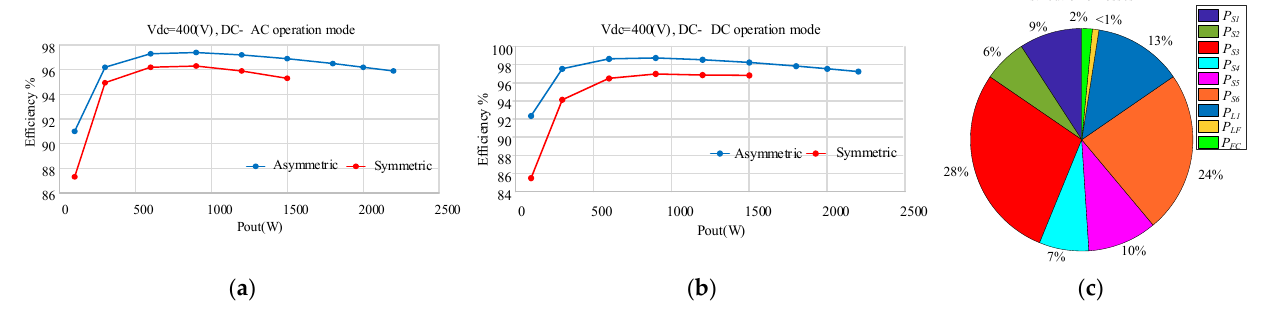
Figure 15. Experimental efficiency curves for 400 V input voltage: ( a ) DC-AC operation, ( b ) DC-DC operation, and ( c ) pie chart of the losses of each of the converter elements as a percentage. Table 3. Parameters for power loss calculation.